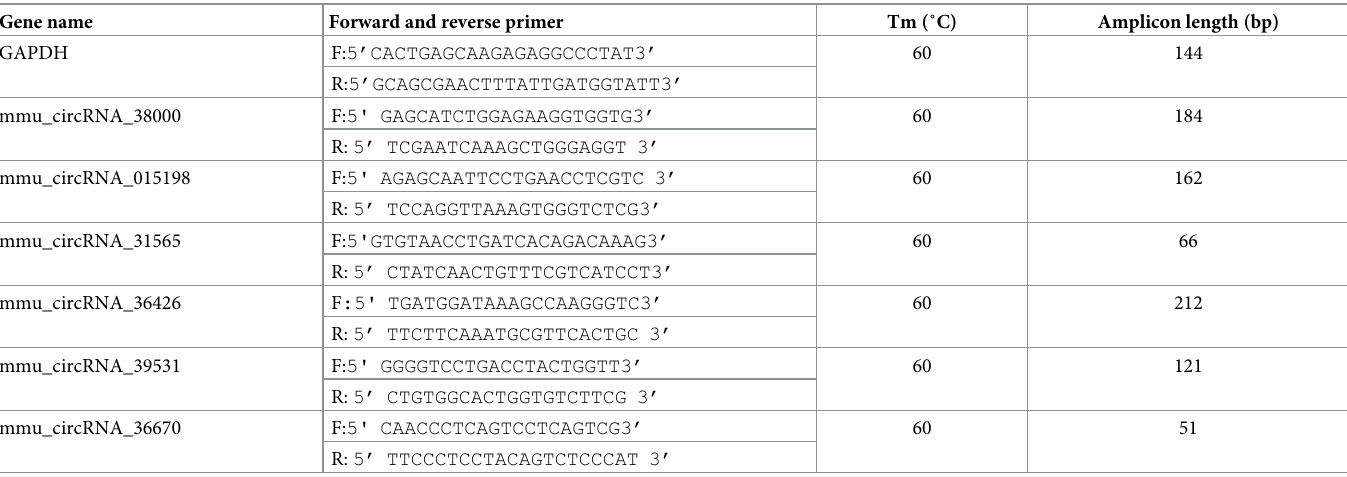
Table 1. Primers designed for